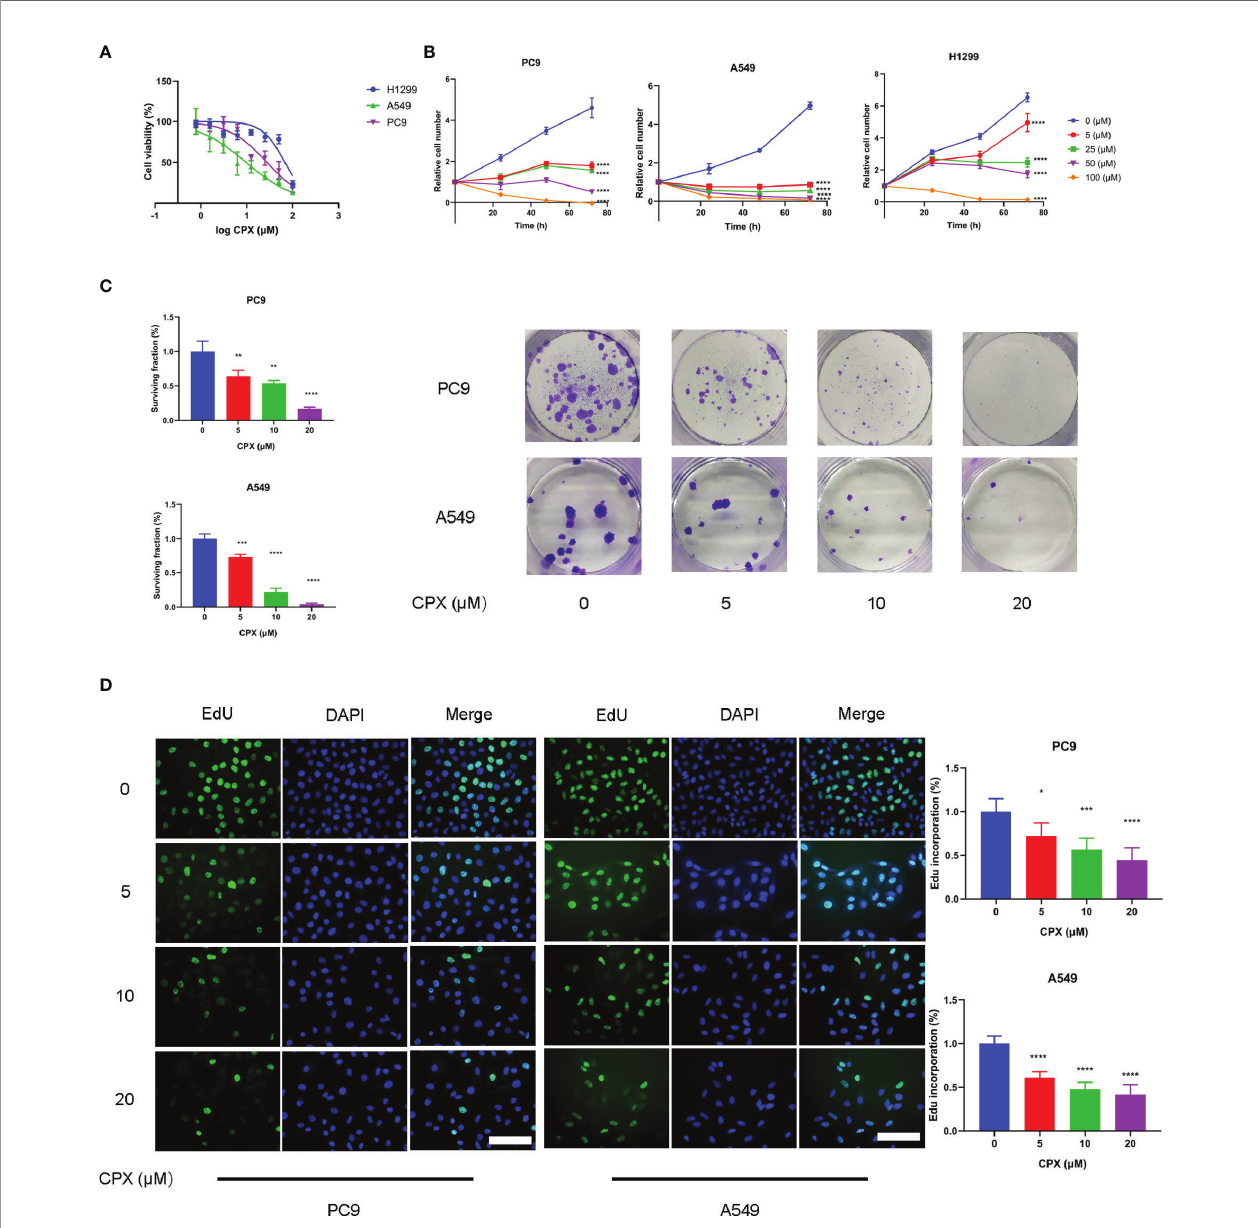
FIGURE 1 | CPX inhibits LUAD cell proliferation in vitro . (A) A549, PC9 and H1299 cells were treated with indicated CPX concentrations for 24 hours, and cell viability was determined by MTT assay. (B) LUAD cells were treated with CPX at the indicated concentration and cell growth was assessed at 24 h, 48 h, and 72 h by MTT assay. (C) Colony formation assay in PC9 and A549 cells treated with indicated CPX concentrations for 24 hours. Cells were seeded in 6-well plates for two weeks and colony numbers quanti fi ed. (D) EdU assay of LUAD cells treated with indicated CPX concentrations for 24 hours and EdU incorporation quantitated. Scale bar = 100 m m. *P < 0.05; **P < 0.01; ***P < 0.001; ****P < 0.0001. Statistical signi fi cance compared with respective control